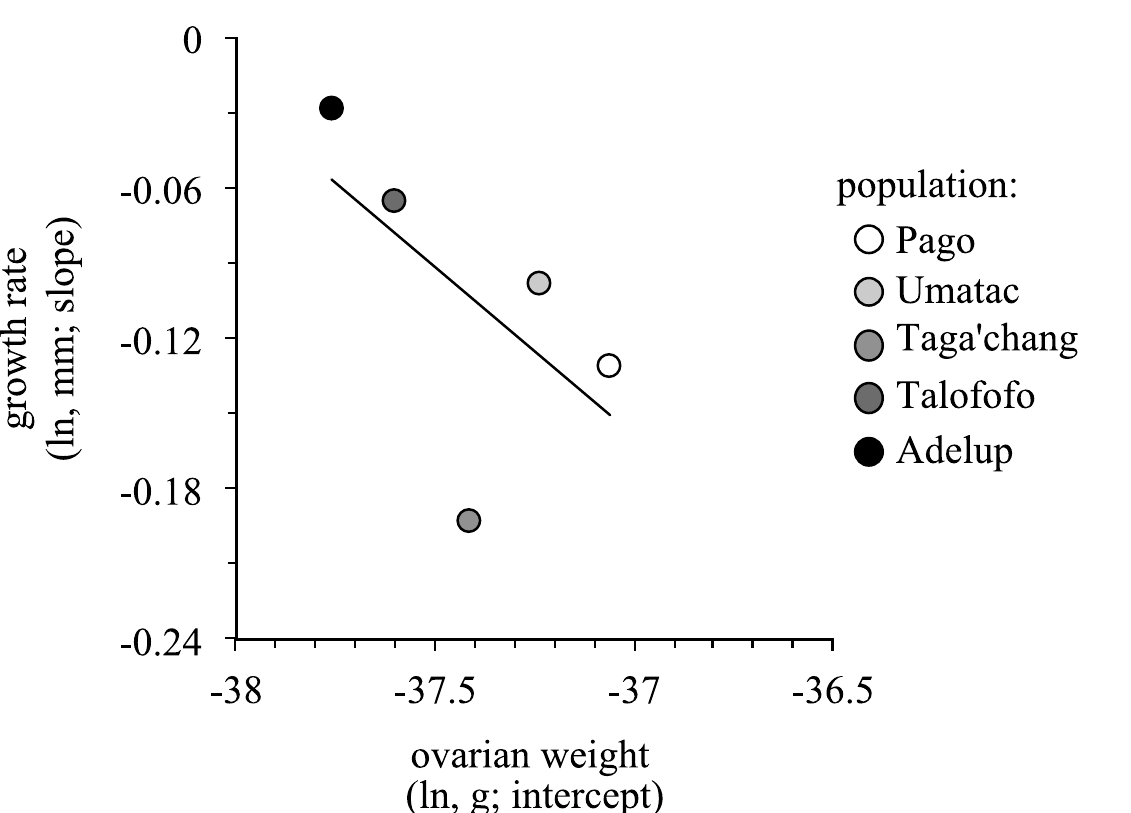
Fig 5. Variation in ovarian weight and growth rate among populations. Plots show population coefficients computed from the best-supported model reported in Tables 1 and 2. Symbols are shaded according to the level of predation, from white (low predation) to black (high